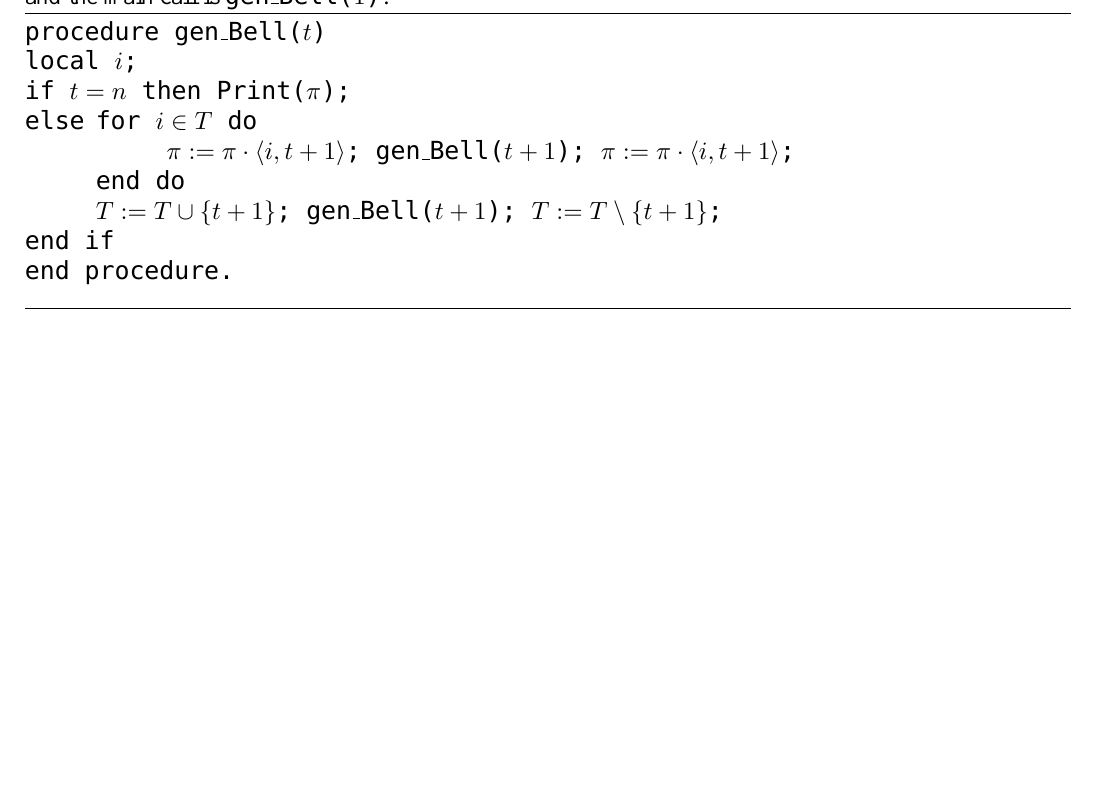
and the main call is gen Bell( 1 )